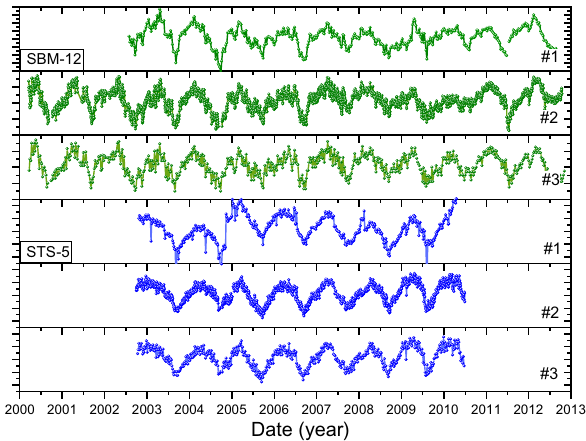
Figure 2. Versions #1, #2, #3 of the decay-corrected count rates from 90 Sr/ 90 Y beta decay detected in the SBM-12 and STS-5 counters. The #1 data were averaged over evenly distributed time intervals. The #2 set was a reanalysis provided by Parkhomov, whereas #3 is a visual analogon of previously published graphs 5 .